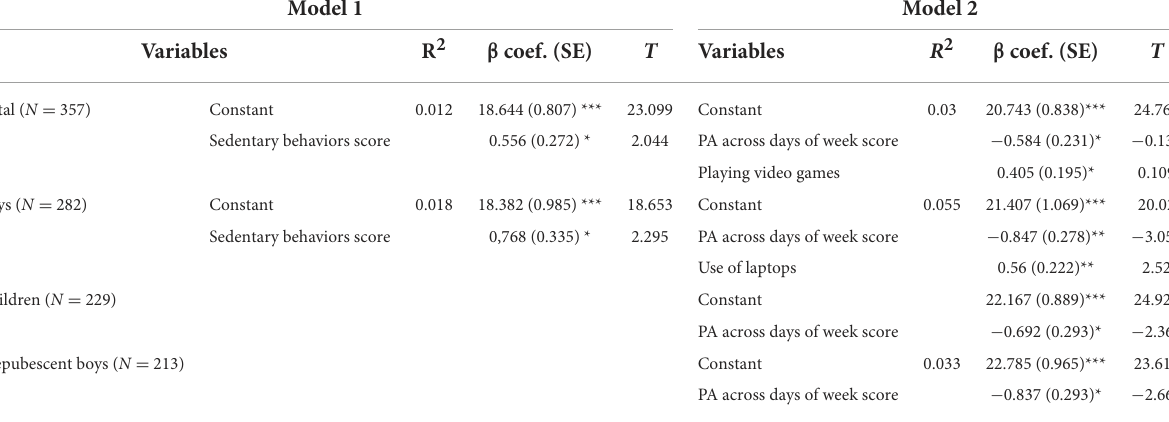
TABLE 3 Stepwise multiple regression analysis models for associations between BMI and physical activity across days of week and sedentary behaviors among Saudi students aged 11–14. Model 1 Model